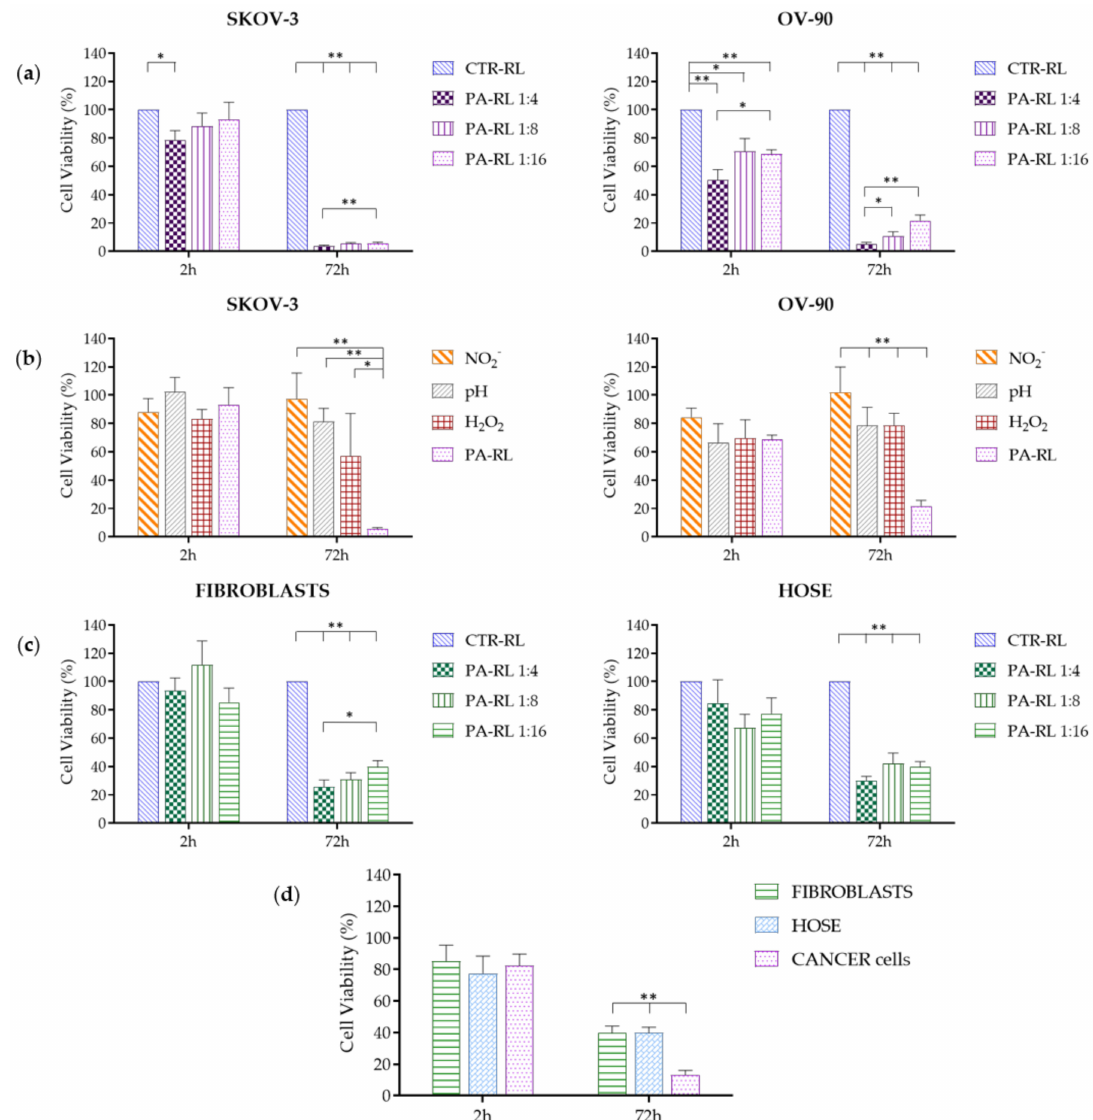
Figure 5. PA-RL displays a selective cytotoxic e ff ect on Epithelial Ovarian Cancer (EOC) cell lines. ( a ) Viability of SKOV-3 ( n = 7) and OV-90 ( n = 9) cell lines treated with PA-RL dilutions (1:4, 1:8 and 1:16). Data are mean ± SEM normalized on the corresponding control in RL (CTR-RL). ( b ) Viability of SKOV-3 and OV-90 cell lines treated with PA-RL 1:16 and synthetic solutions at dilution 1:16. H 2 O 2 -supplemented RL, NO 2 − -supplemented RL and pH-adjusted RL solutions were diluted in RL to obtain the final treatment solutions. Data are mean ± SEM ( n = 3) normalized on the corresponding CTR-RL. ( c ) Viability of non-cancer cells, namely human fibroblasts ( n = 9) and HOSE ( n = 4) treated with di ff erent PA-RL dilutions (1:4, 1:8 and 1:16). Data are mean ± SEM normalized on the corresponding CTR-RL. ( d ) PA-RL 1:16 e ffi cacy on cell viability in non-cancer and EOC cell lines. Cell viability was normalized to the CTR-RL at 2 h and plotted as percentage relative to the corresponding CTR-RL, for both time points. In each panel, data are mean ± SEM and statistical significance is specified with asterisks (* p ≤ 0.05, ** p ≤ 0.001 as determined by a paired Student’s t